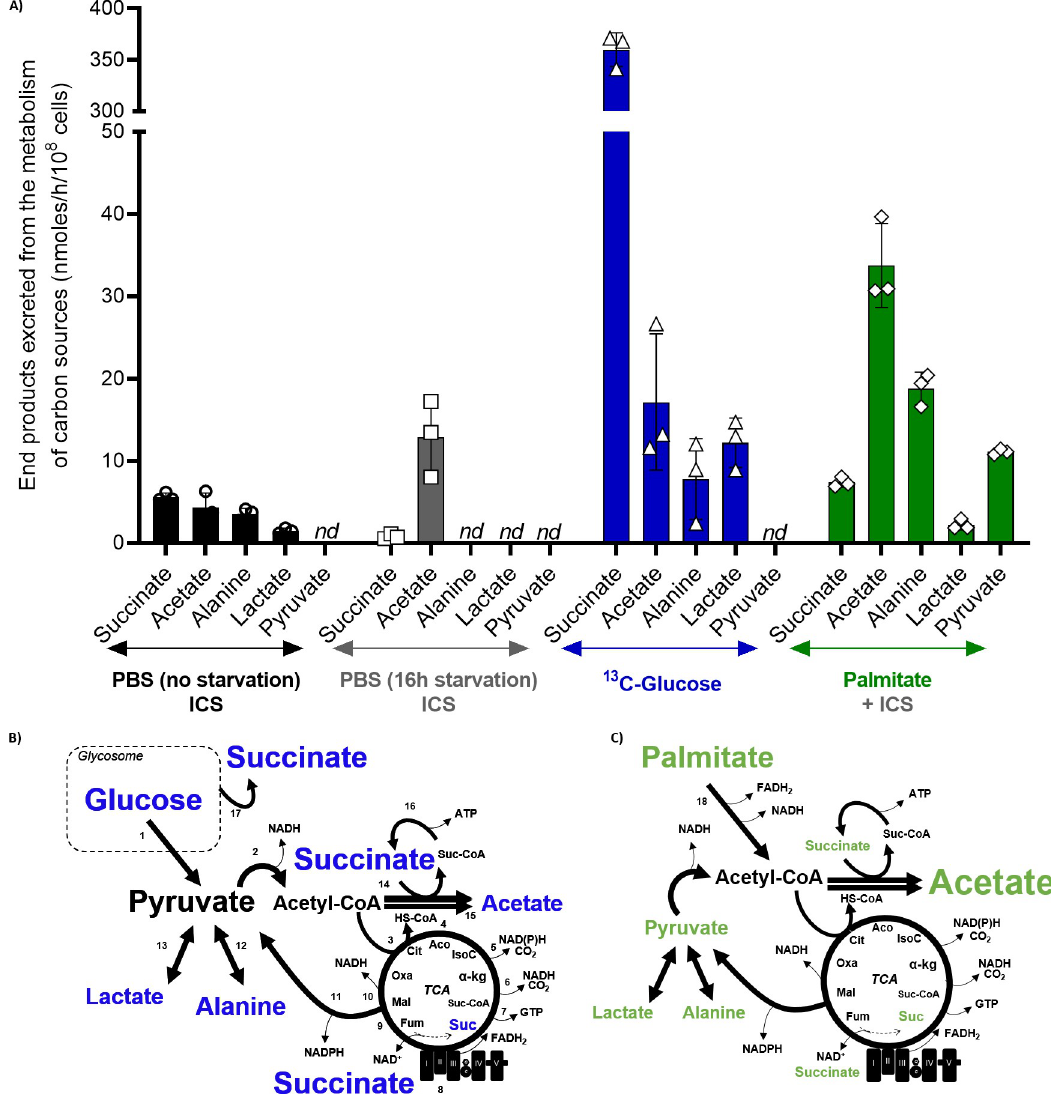
Fig 2. Excreted end products of glucose and palmitate metabolism in epimastigote forms of T . cruzi . A) The extracellular medium of epimastigote forms incubated under different conditions was analysed by 1 H-NMR spectrometry to detect and quantify the end-products. The resulting data were expressed in nmoles/h/10 8 cells. Means ± SD of three independent experiments. ICS is internal carbon sources; nd is non-detectable. B) and C) Schematic representation of the contribution of glucose and palmitate to the metabolism of epimastigote forms of T . cruzi . The glycosomal compartment and TCA cycle are indicated. The amount of end- product determined by the font size. Numbers indicates enzymatic steps. 1. Glycolysis; 2. pyruvate dehydrogenase; 3. citrate synthase; 4. aconitase; 5. isocitrate dehydrogenase; 6. α -ketoglutarate dehydrogenase; 7. succinyl-CoA synthetase; 8. Succinate dehydrogenase/complex II/fumarate reductase NADH-dependent; 9. fumarate hydratase; 10. malate dehydrogenase; 11. Malic enzyme; 12. alanine dehydrogenase/alanine aminotransferase; 13. lactate dehydrogenase; 14. acetate:succinyl-CoA transferase; 15. acetyl-CoA hydrolase; 16. succinyl-CoA synthetase; 17. Glycosomal fumarate reductase and 18. Palmitate oxidation by beta- oxidation, resulting in FADH 2 , NADH and acetyl-CoA; Abbreviations: Cit: Citrate, Aco: Aconitate, IsoC: Isocitrate, α -kg: α - Ketoglutarate, Suc-CoA: Succinyl-CoA, Suc: Succinate, Fum: Fumarate, Mal: Malate, and Oxa: Oxaloacetate.